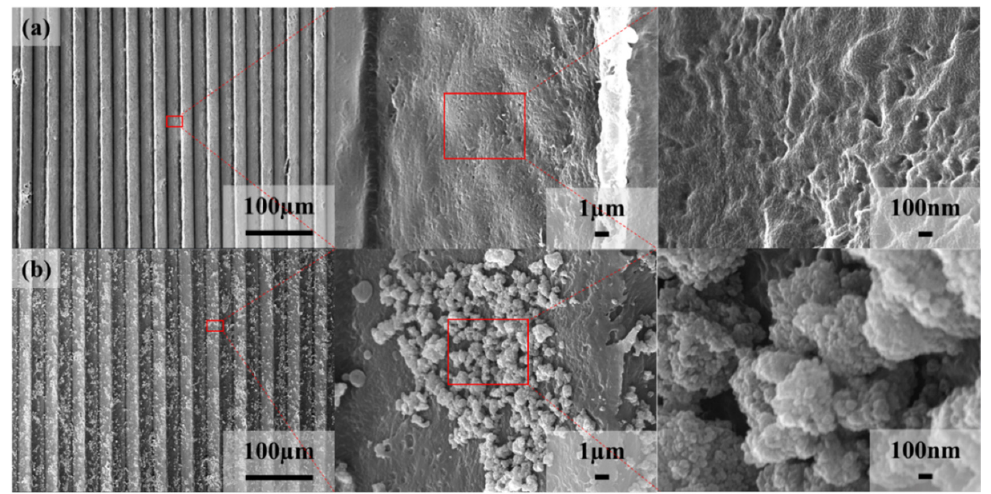
Figure 6. SEM images of the replicated surfaces: ( a ) before and ( b ) after dip coating.